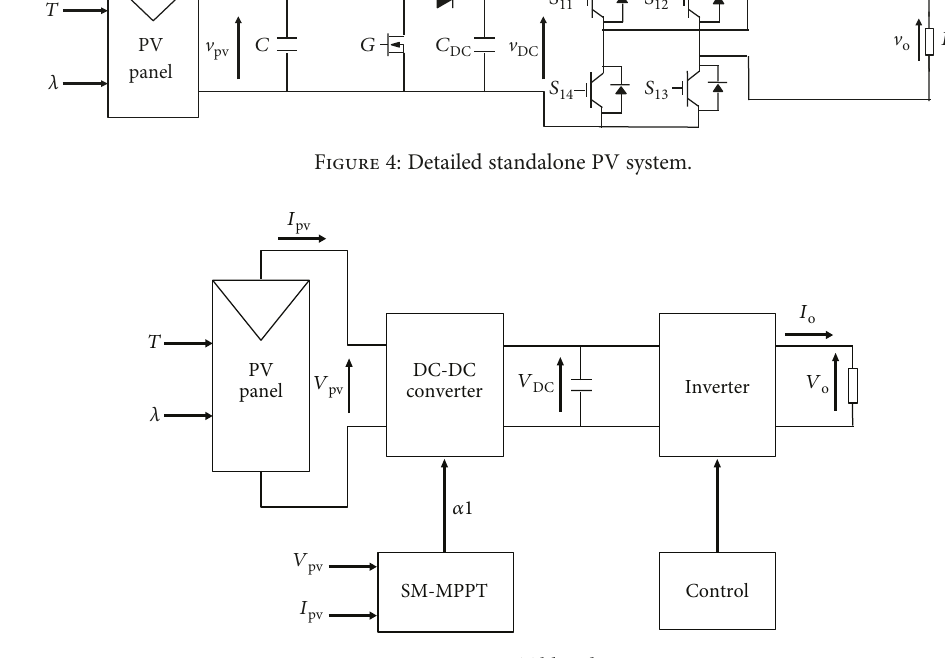
Figure 5: SM-MPPT bloc